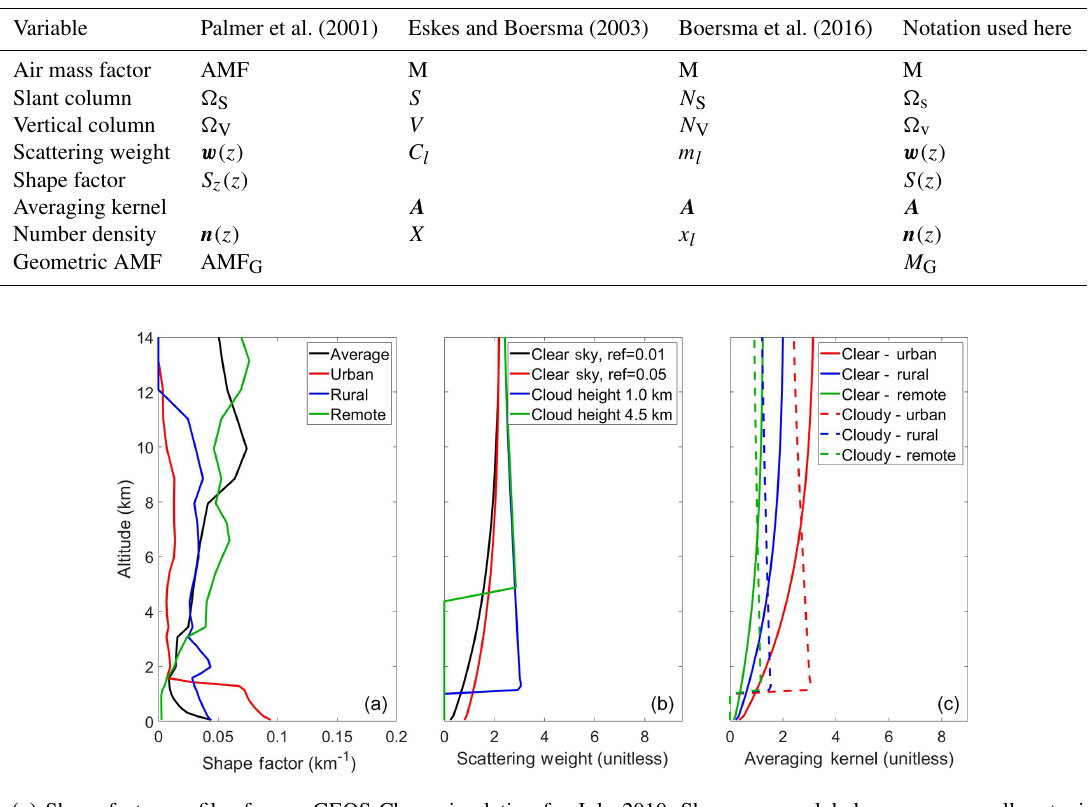
Figure 1. (a) Shape factor profiles from a GEOS-Chem simulation for July 2010. Shown are a global average, as well as typical urban (Beijing), rural (Midwest USA), and remote (tropical Pacific) profiles. (b) Typical Ozone Monitoring Instrument (OMI) scattering weight profiles for varying surface reflectance and cloud height. (c) Averaging kernels calculated using the same shape factors and scattering weights (clear-sky surface reflectance is 0.01; cloudy uses a cloud height of